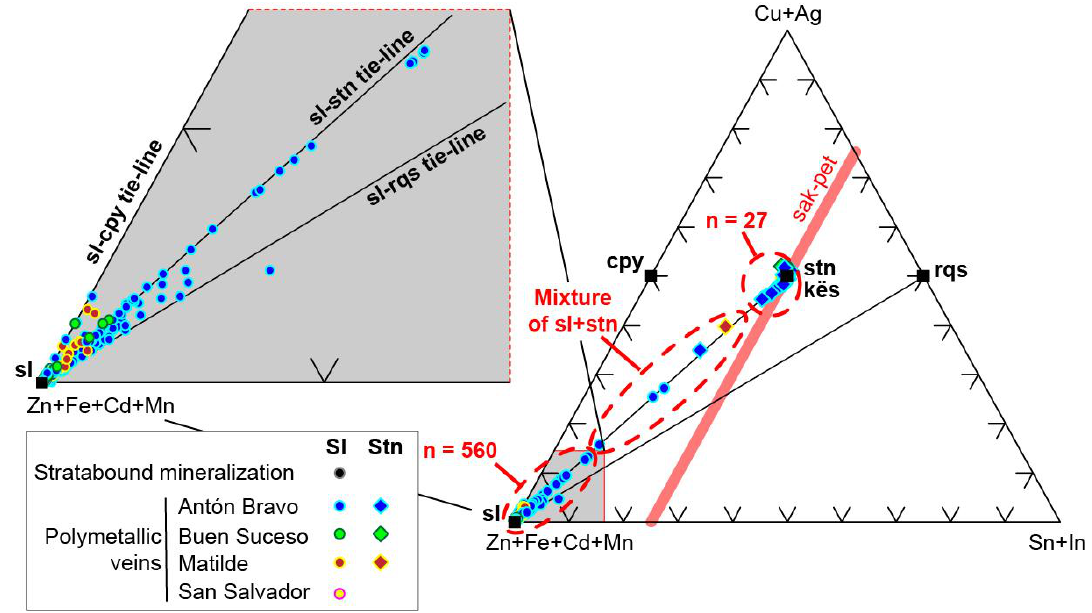
Figure 8. Plot of the analyzed sphalerite and stannite grains from the Huari Huari district in the Zn + Fe + Cd + Mn vs. Cu + Ag vs. Sn + In ternary diagram. The composition of mineral end-members of interest is also plotted and includes chalcopyrite (cpy), kësterite (kës), roquesite (rqs), sphalerite (sl), and stannite (stn). The compositional variation of sakuraiite (sak) and petrukite (pet) is also shown (bold, red line).